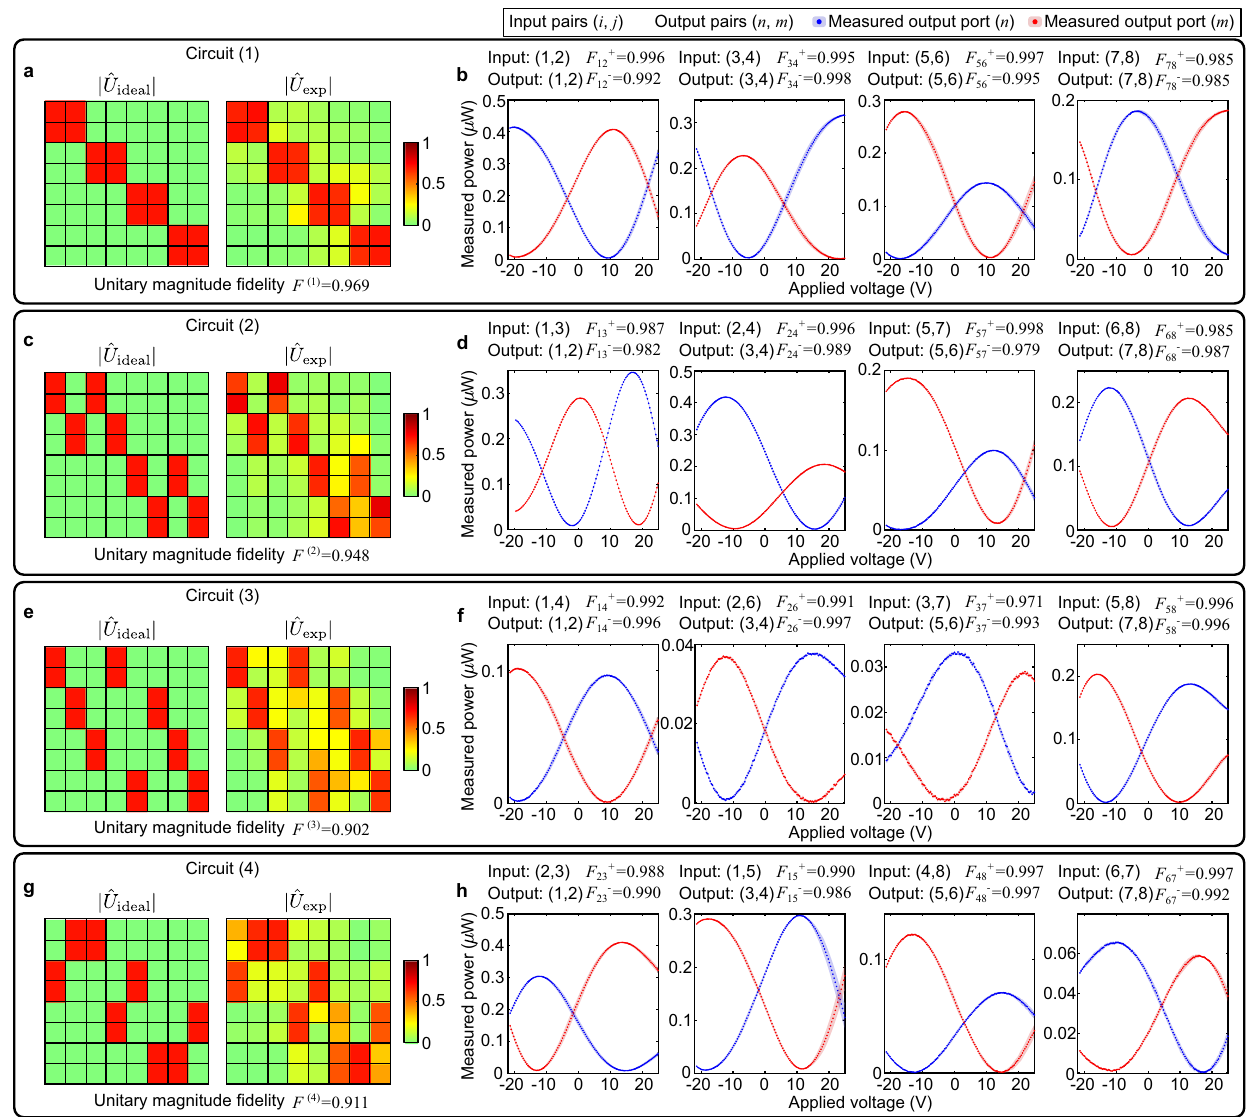
Fig. 4 Fidelities of the four programmed OHQE circuits. a Color map of ideal and experimental unitaries and the measured unitary fi delity of circuit (1). b Measured intensity at the four output pairs of Hadamard operations of circuit (1) while performing an input phase sweep. Optical inputs and outputs are labeled with the convention ( A , B ), where A and B are port numbers. The resulting link fi delities F ± displayed. c – h are the measurements in a , b but for circuits (2), (3), and (4) respectively, demonstrating 16 independent connections. The average optical link fi delity of all 32 interference curves is 0.991 ±